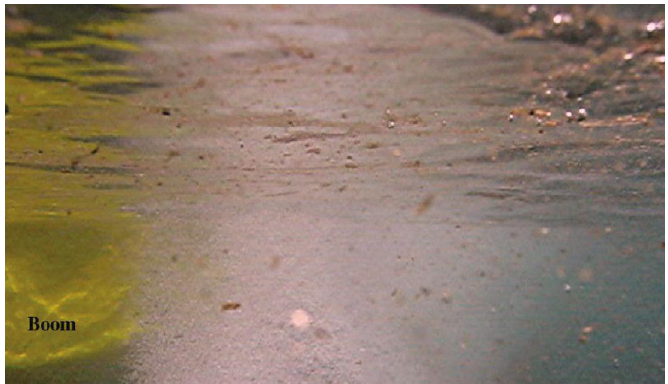
Figure 24: Image of submerged (dispersed) oil in the Coal Oil Point seep fi eld during a bubble oil boom test, described in McClimans et al. [238]. Foreground oil emulsion globules are a few millimeters across. Photo is red contrast-enhanced to highlight oil. Photo: Ira Leifer.